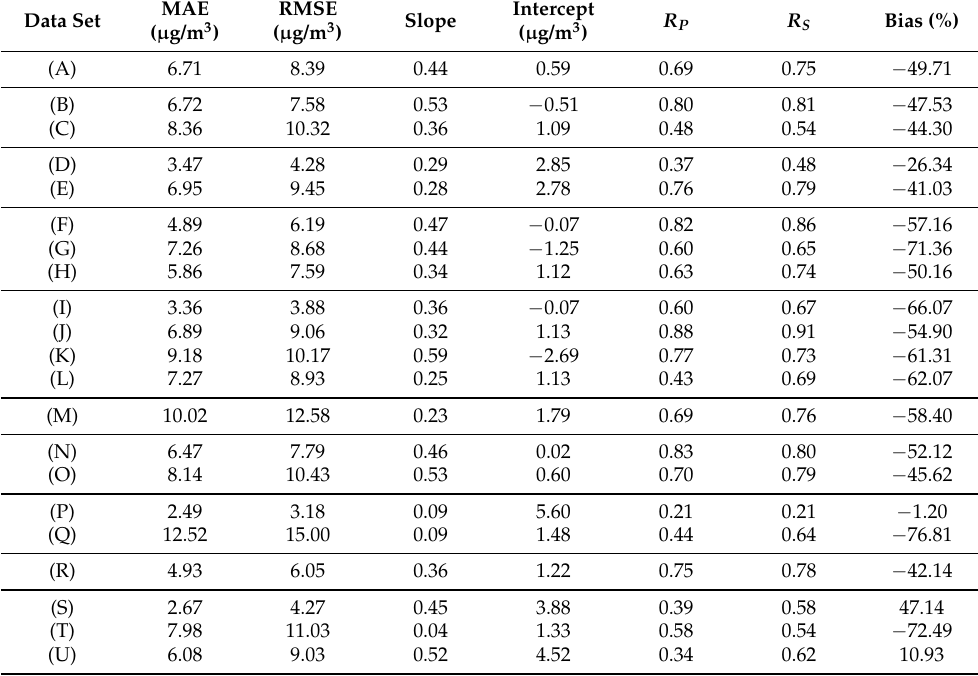
Table 8. Results of statistical analysis of pilot data against in-luft data for data collected between May and December 2021. Fixed percentile filtering method (99.0%) is applied to the raw data. No further calibration